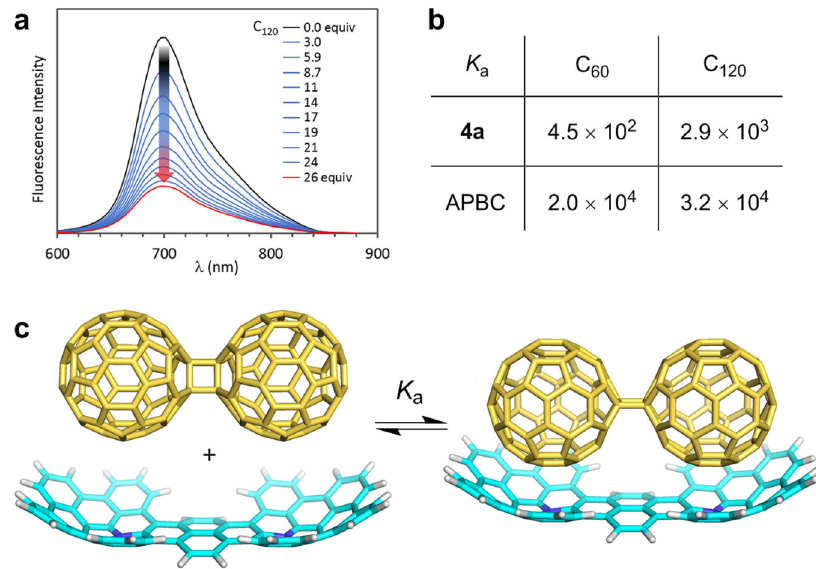
Fig. 7 Host – guest chemistry between 4a and C 120 . a Fluorescence spectra of 4a upon titration with C 120 . b Association constants of host molecules ( 4a and APBC) and guest molecules (C 60 and C 120 ) determined by fl uorescence titration. c One of the possible association modes of 4a and C 120 determined by DFT calculation at the B3LYP/6-31G(d) level with Grimme ’ s D3 dispersion